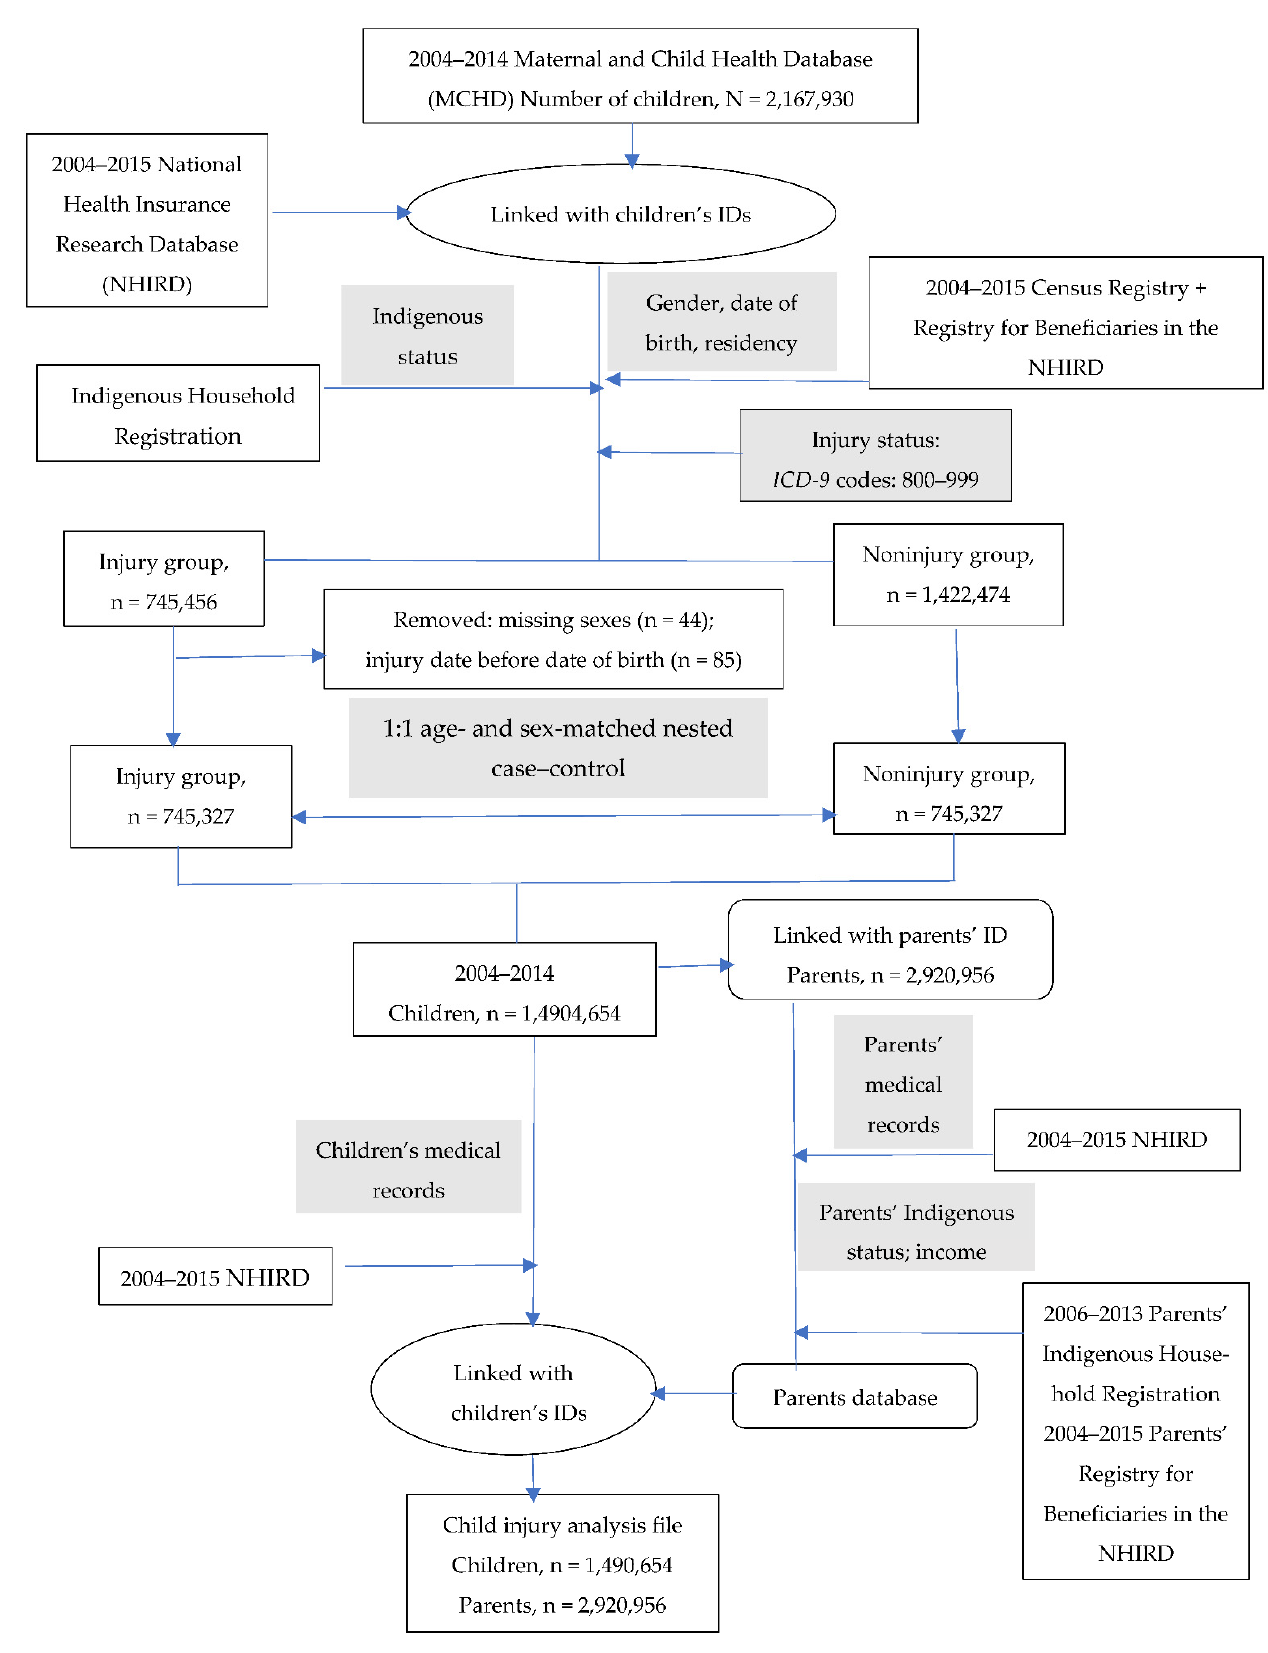
Figure 1. Study data flowchart.